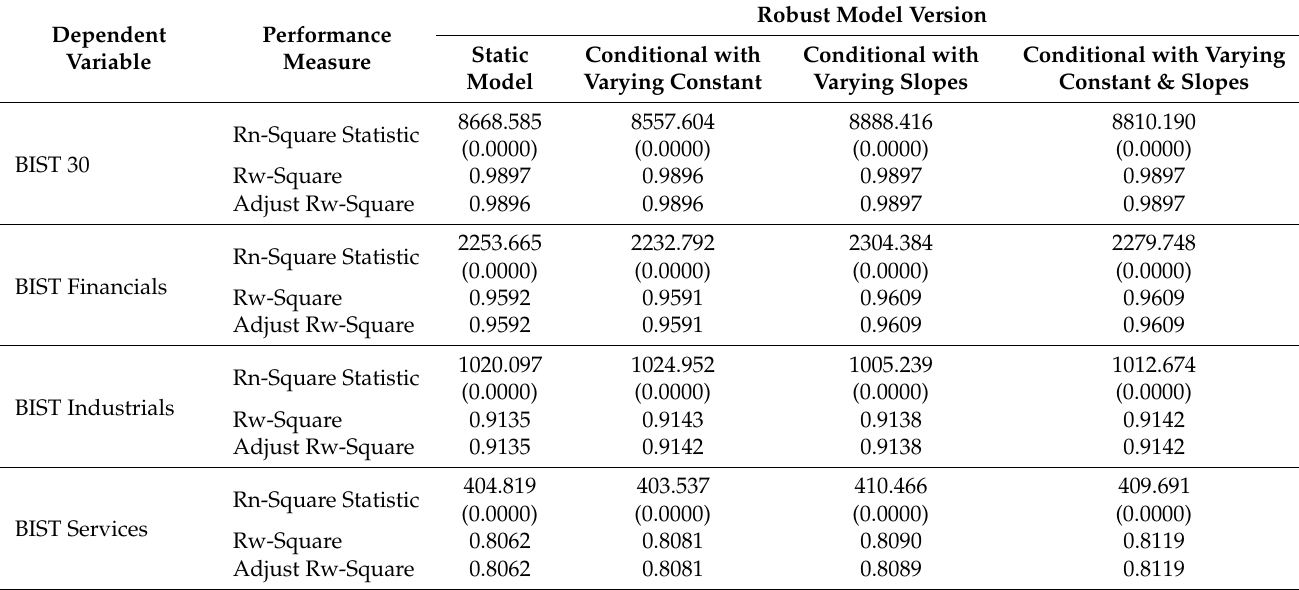
Table 4. Comparison of robust regression models.